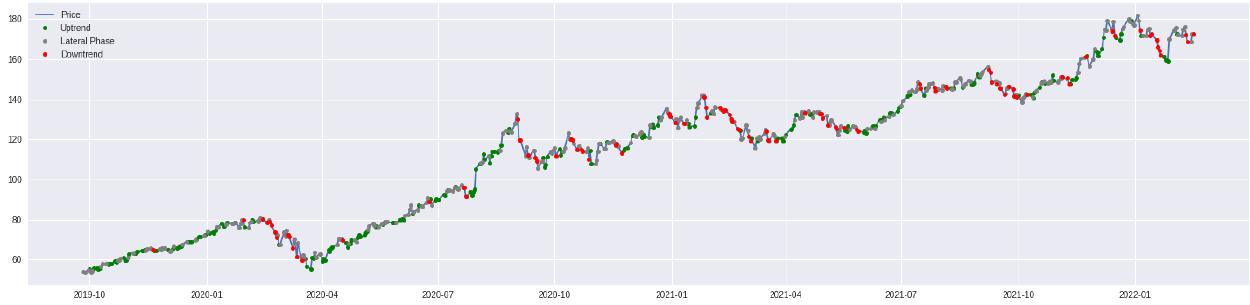
Figure 5. Example of the resulting labeling for